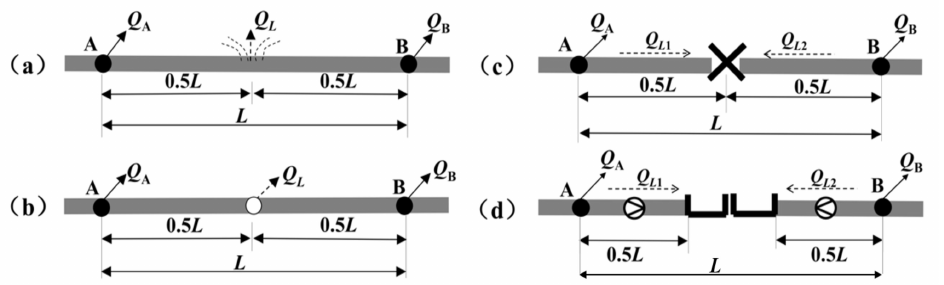
Figure 5. Diagram of pipeline damages and the hydraulic model of damages. ( a ) Diagram of leak. ( b ) Hydraulic mode of leak. ( c ) Diagram of break. ( d ) Hydraulic mode of